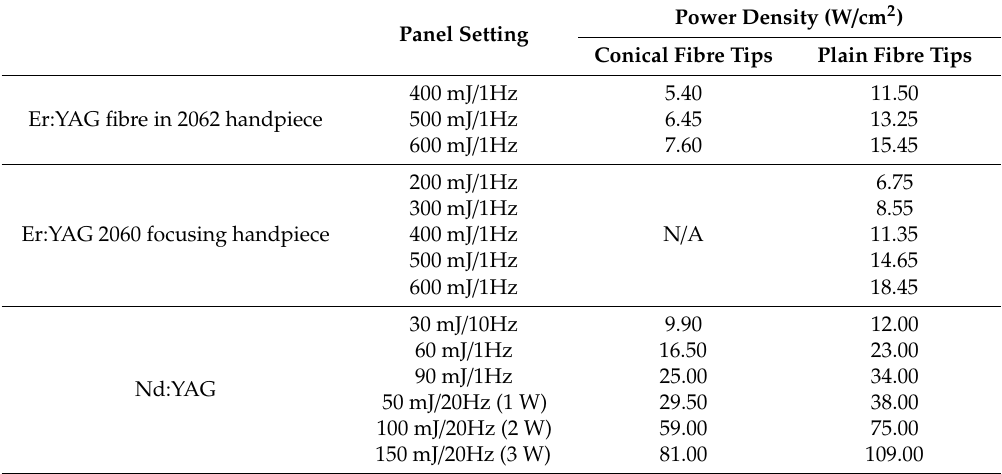
Table 2. Power density for laser